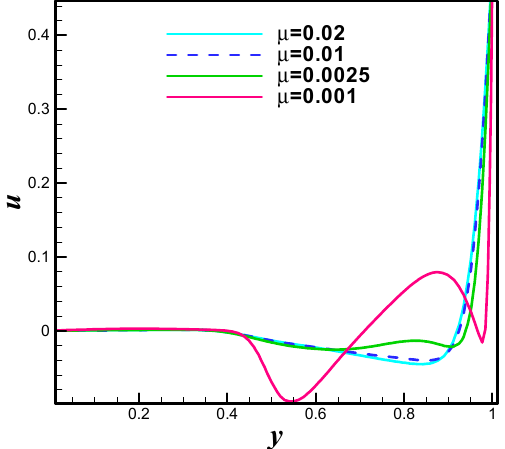
Figure 19. The u - velocity profile for case-I. Figure 19. The u -velocity profile for